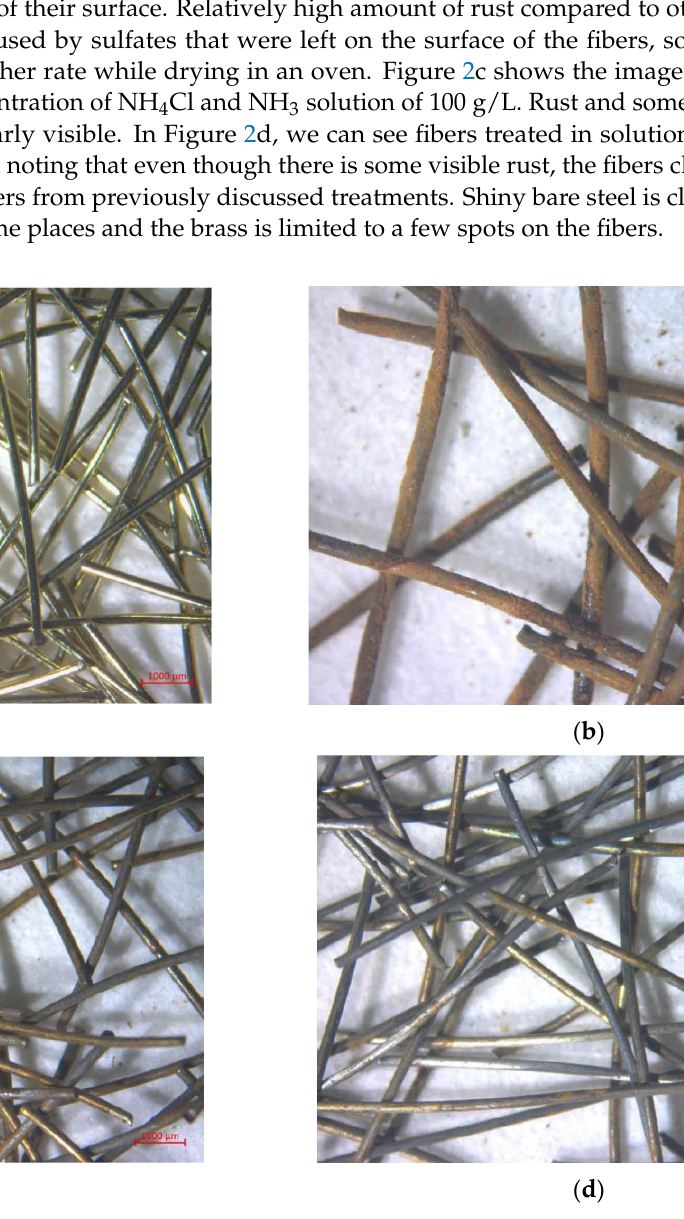
Figure 2. First set of mages from optical microscopy of chemically treated fibers ( a ) untreated ( b ) H 2 SO 4 ( c ) NH 4 Cl ( d ) (NH 4 ) 2 CO 3. H 2 SO 4 ( c ) NH 4 Cl ( d ) (NH 4 ) 2 CO 3